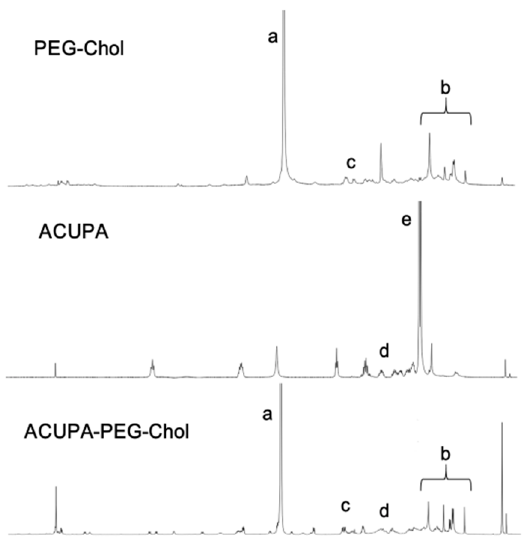
Figure 2. The 1 H NMR spectrum of 2-(3-(( S )-5-amino-1-carboxypentyl)ureido)pentanedioic acid (ACUPA) modified (ACUPA-PEG-Chol), ACUPA and polyethylene glycol (PEG)-Cholesterol (Chol) (PEG-Chol).